Question: What caption would you write for this figure?
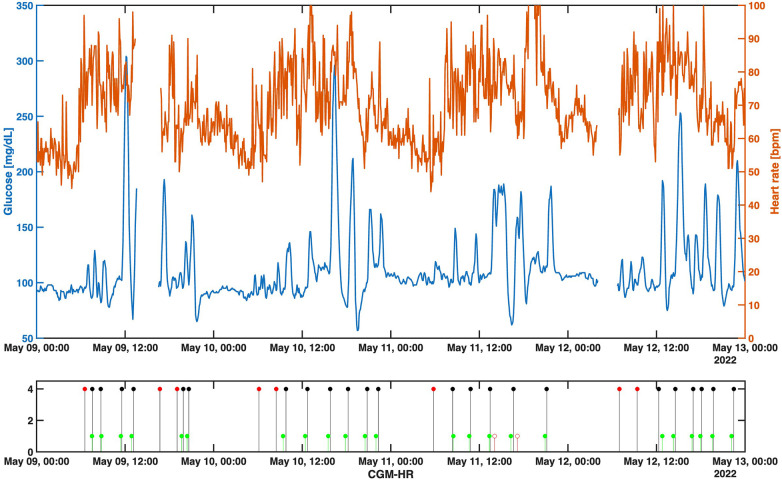
Answer: Meal detection performance example in the free-living conditions (zoom on 4 days). On the top chart, the glucose and heart rate (HR) signals are depicted in blue and red, respectively. In the bottom panel, the detected events by the proposed algorithm are shown with the following color-coding: actual meal events (black stem and dots); false negative detections (black stem and red dot); true positives (green stem and dot); false positives (red stem and dot).